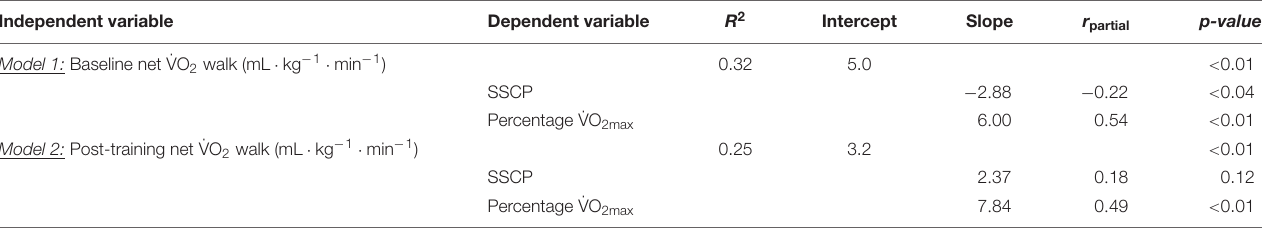
TABLE 3 | Multiple linear regression model of walking net ˙VO 2 versus stretch-shortening cycle potentiation (SSCP) and relative exercise intensity (%˙VO 2max ) at baseline ( n = 92) and post-training ( n =